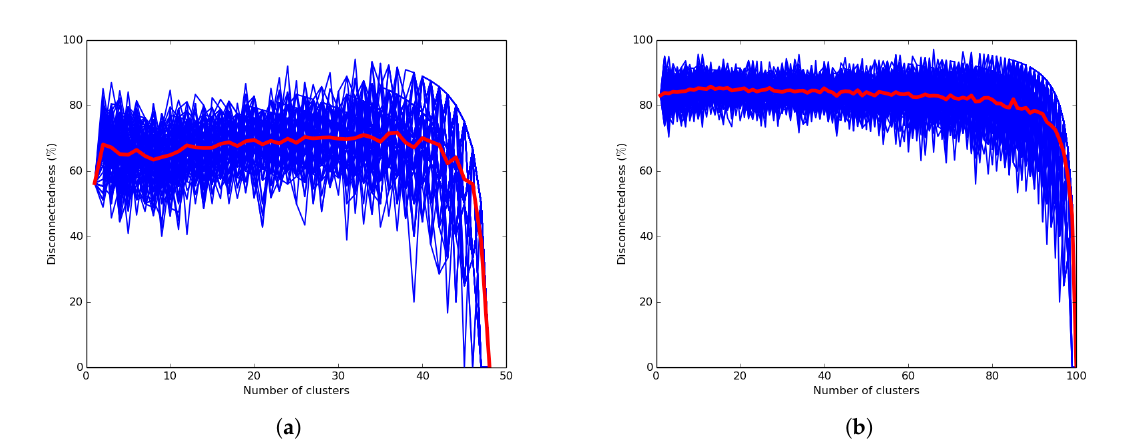
Figure 16. K-means algorithm. ( a ) Average disconnectedness: Cape Town network; ( b ) average disconnectedness: random network.